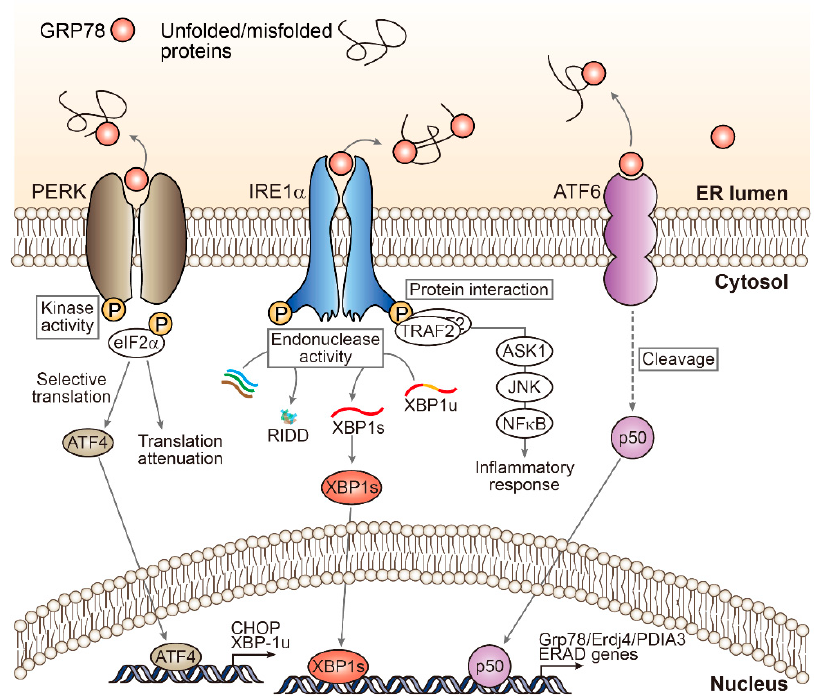
Figure 1. “Canonical” arms of endoplasmic reticulum (ER) stress signaling and unfolded protein response (UPR). The most upstream transmembrane kinases activated by ER stress. Although there is a myriad of signaling network triggered by ER stress, protein kinase RNA-like ER kinase (PERK), inositol-requiring enzyme 1 (IRE1 α ) , and activating transcription factor (ATF6) ignite most of the downstream effector pathways. IRE1 α degrades multiple mRNAs in a process called regulated IRE1 α -dependent decay (RIDD), which results in reduced nascent protein load. Similarly, phosphorylation of eIF2 α by PERK induces global attenuation of translation to slow down protein synthesis. Each of the three arms is capable of changing cellular transcriptome by distributing respective transcription factor(s) into the nucleus.